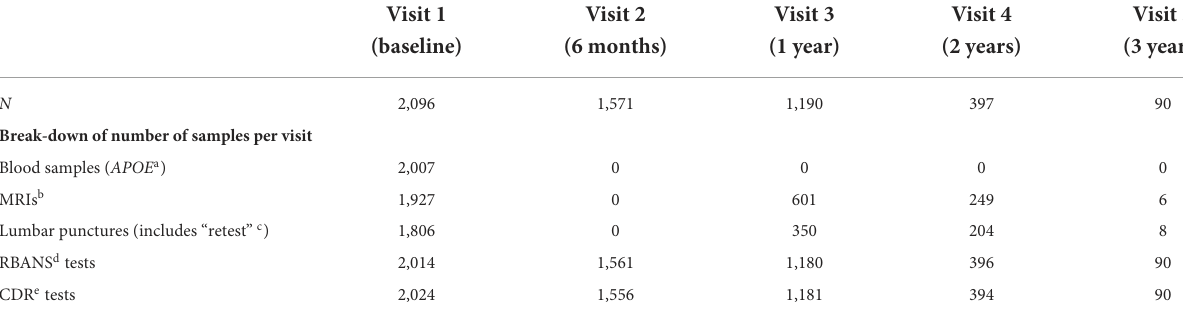
TABLE 2 Number of completed research participant visits and availability of key assessment data at each visit (8).